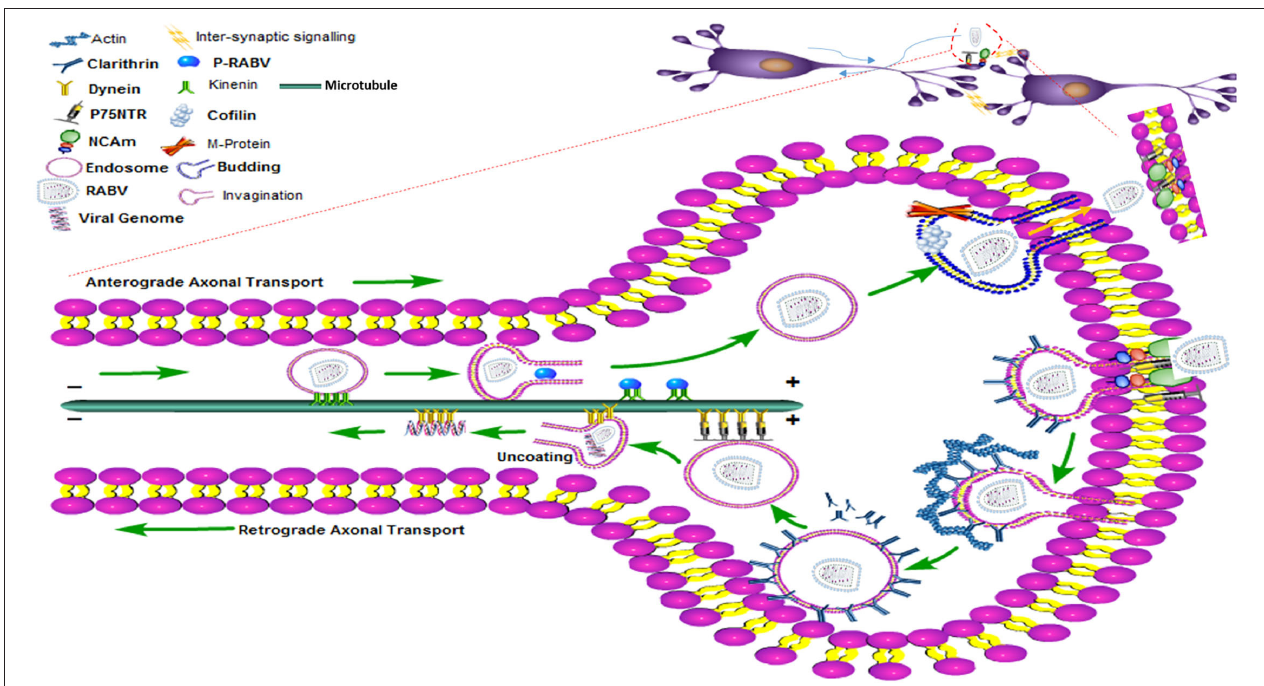
FIGURE 3 | The clathrin-mediated endocytosis and the transport (anterograde and retrograde) pathway of RABV within the nerve cell showing motor proteins, entry and exist paths of the RABV with the help of the cytoskeleton